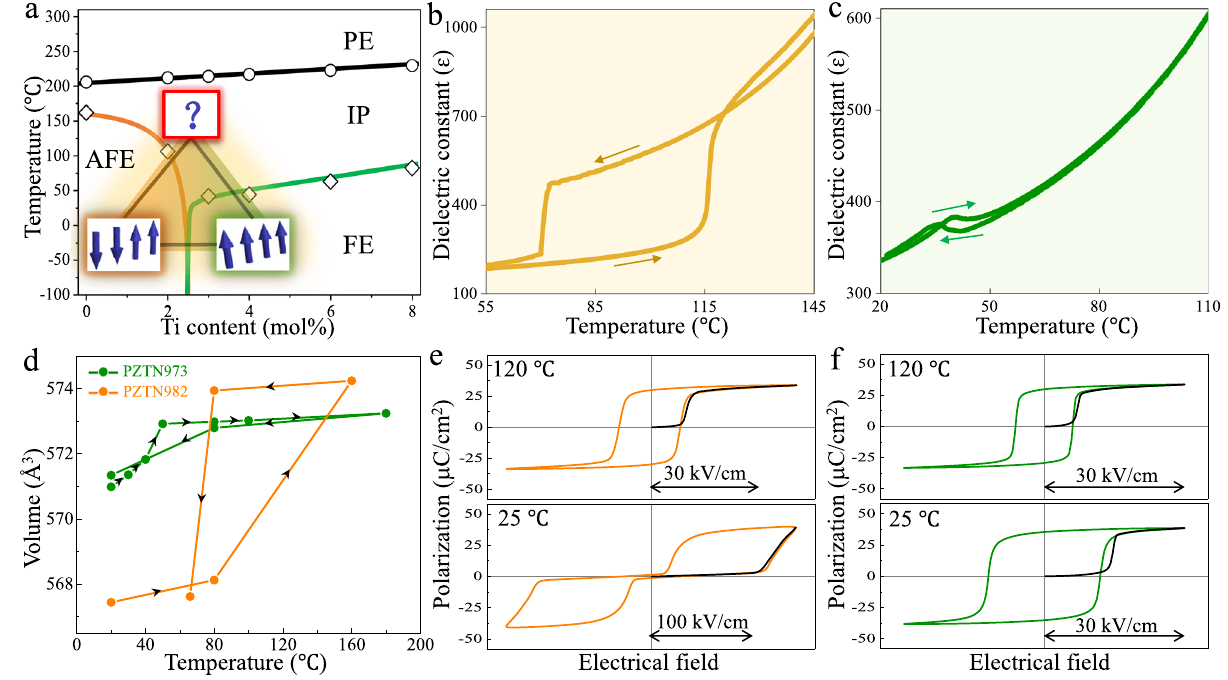
Fig. 1 Macroscopic electric measurements. a Phase diagram of Pb 0.99 (Zr 1-x Ti x ) 0.98 Nb 0.02 O 3 solid solution in composition range from x = 0 to x = 0.08. The PE, IP, AFE, and FE refer to paraelectric, intermediate, antiferroelectric, and ferroelectric phases, respectively. The blue arrows highlight the different arrangement of dipoles in AFE and FE phases. b , c The variations of dielectric constant for increasing and subsequently decreasing temperature spanning the phase transitions of IP-AFE and IP-FE for PZTN98/2 and PZTN97/3, respectively. d Lattice volumes (2a p × 2 b p × 2c p ) of PZTN98/2 and PZTN97/3 as a function of temperature. e , f Temperature-dependent hysteresis loops for PZTN98/2 and PZTN97/3, respectively. The black curves indicate the polarization response for initial